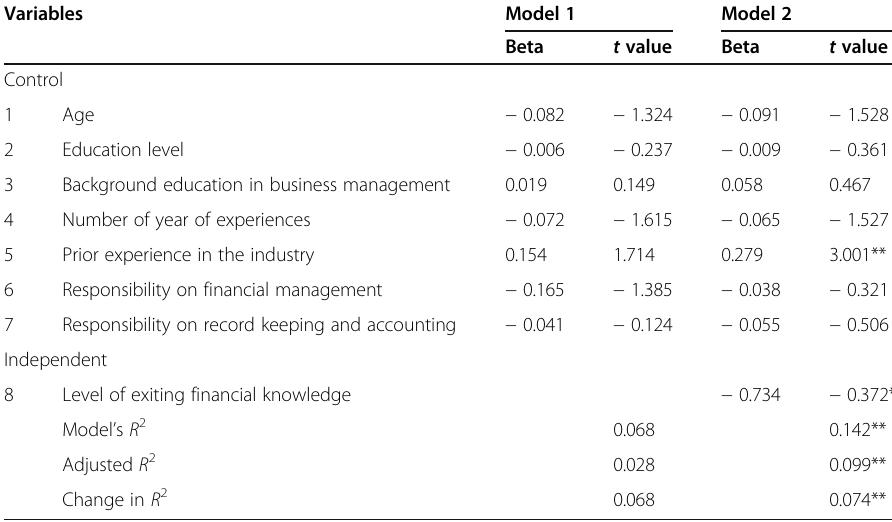
Table 4 Regression: Level of financial knowledge